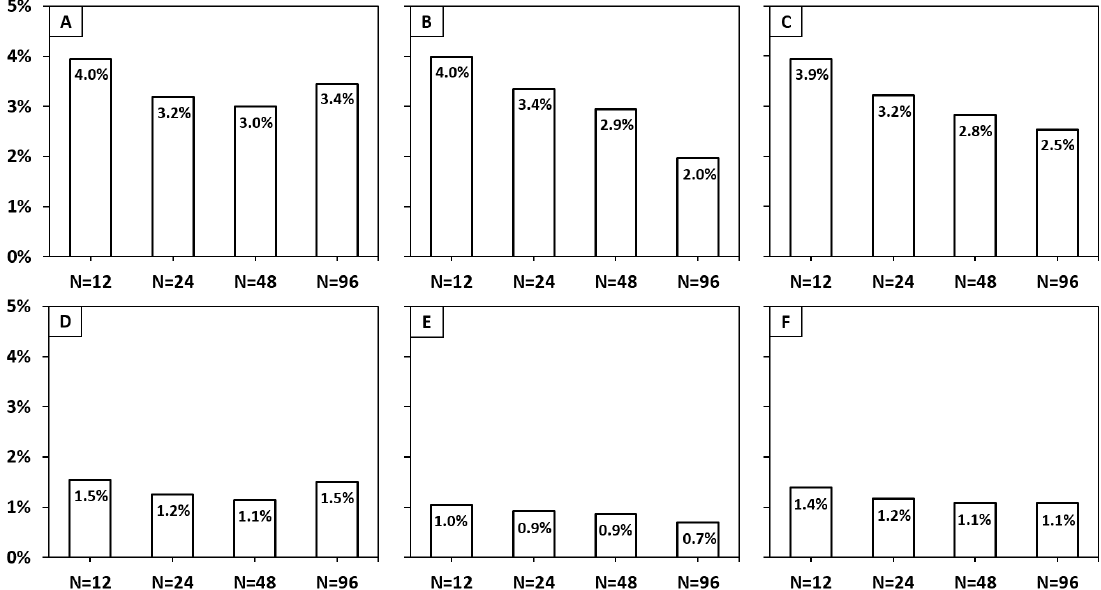
*Deviation of average debarking percentages from 75% for wood and 25% for bark polygon measurements under controlled conditions.